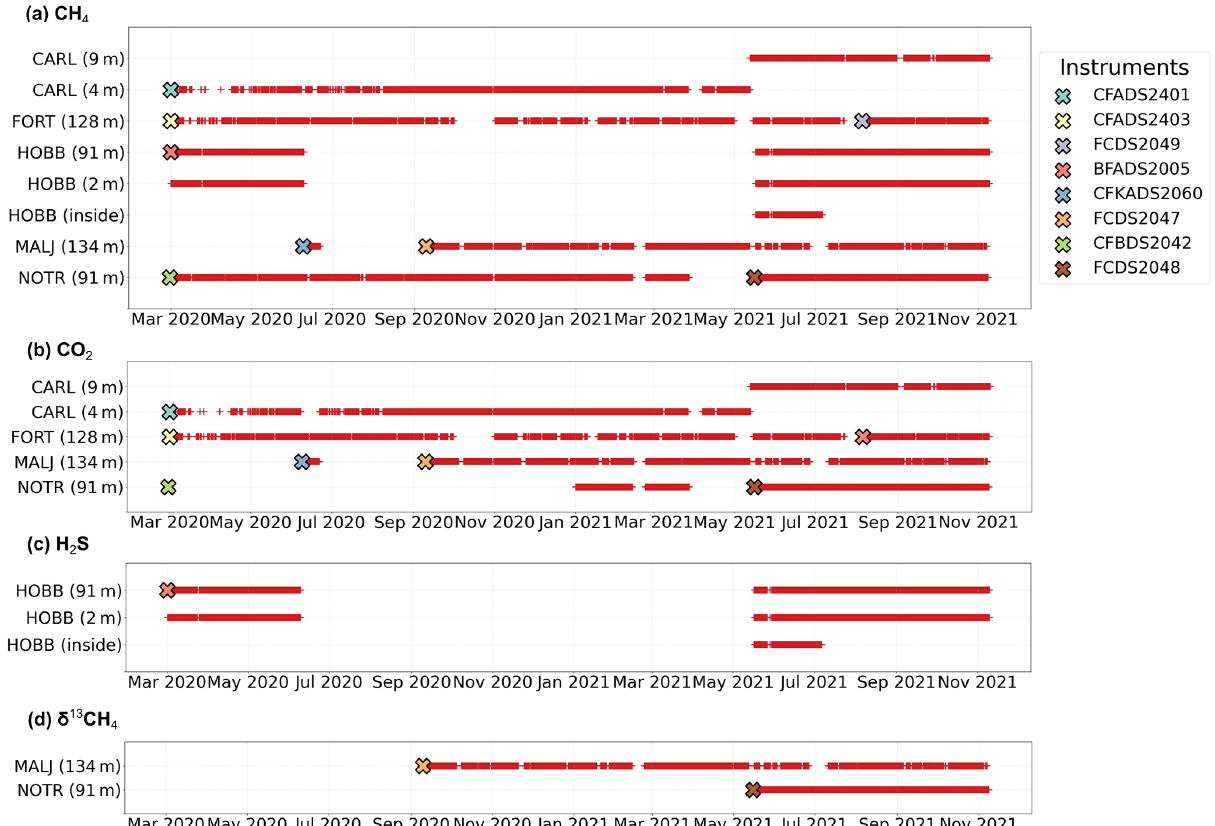
Figure 4. Data availability and instruments used at each site. Inlet level (meters above ground level) is indicated beside the site name. (a) Methane (CH 4 ) data availability at all sites. (b) Carbon dioxide (CO 2 ) data availability. (c) Hydrogen sulfide (H 2 S) data availability. (d) Methane isotope ( δ 13 CH 4 ) data availability. At the sites with more than one level of measurement (e.g., HOBB and CARL), all the levels operate using the same instrument at that site. Instruments replacements were made due to instrument failures at FORT, MALJ, and